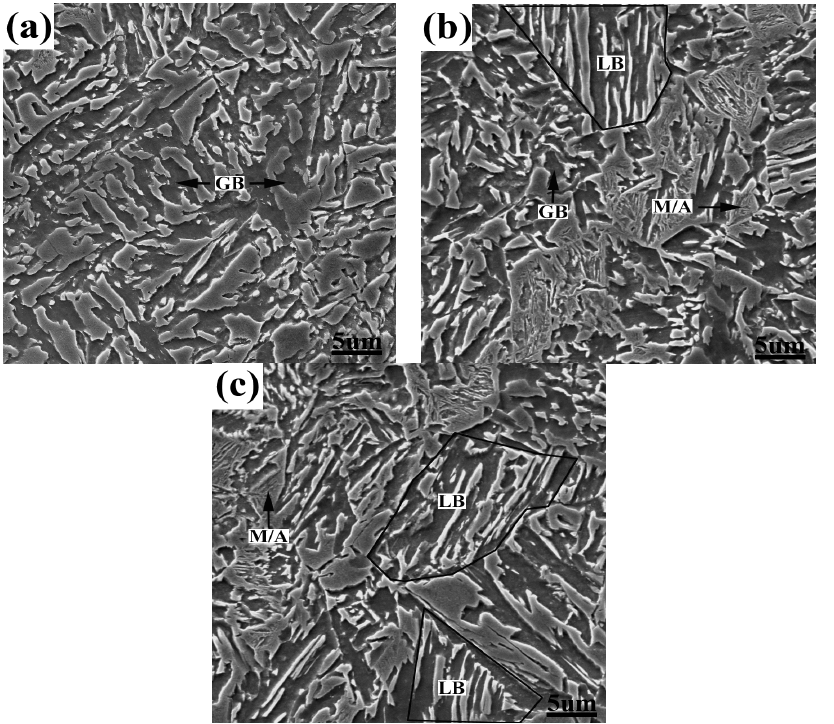
Figure 2. SEM micrographs of steels with different Mo contents: ( a ) steel #1, Mo ‐ free; ( b ) steel #2, 0.134 wt. % Mo; ( c ) steel #3, 0.273 wt. % Mo.